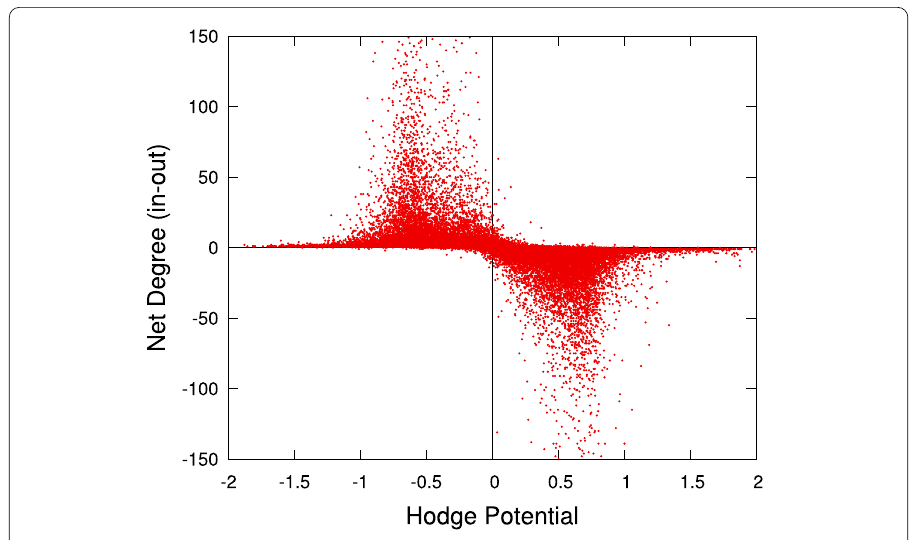
Figure 9 Hodge potential and net degree for each node. Each point represents a node or an account. The net degree is defined by the difference between the in-degree and the out-degree of the node. If the net degree is positive, the node has more incoming links than outgoing ones and vice versa